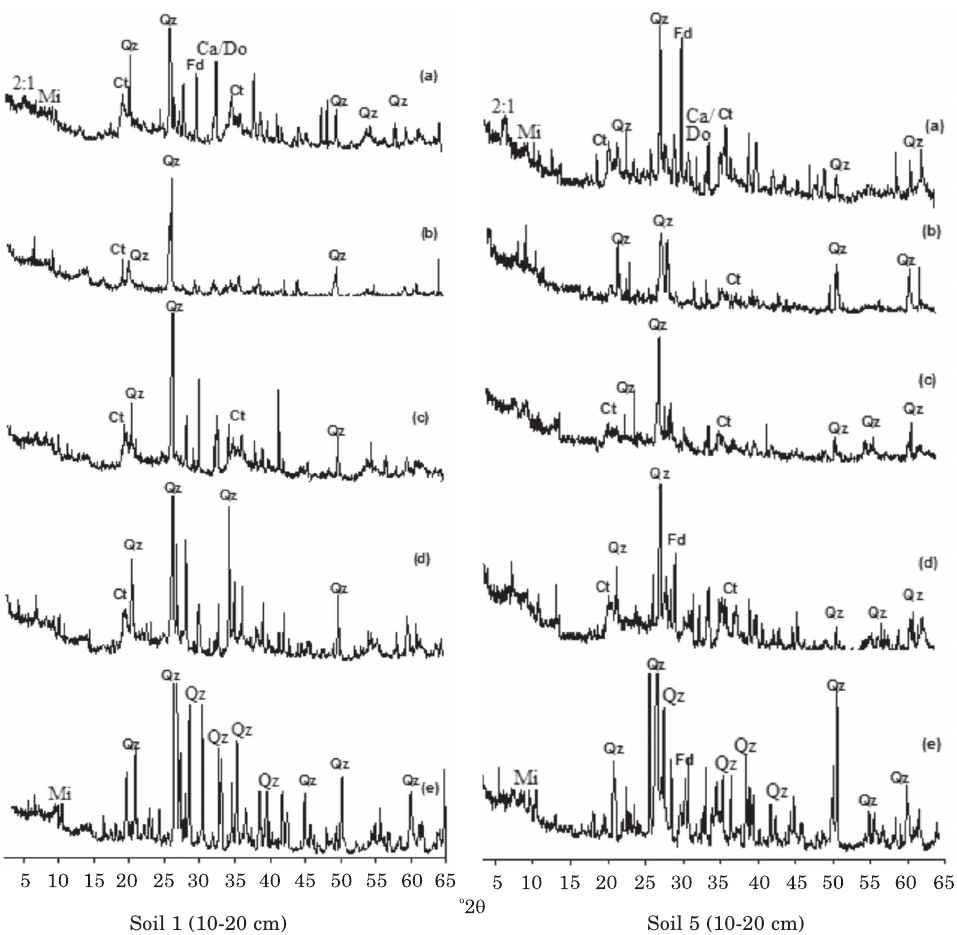
Soil 1 (10-20 cm) Soil 5 (10-20 Figure 3. X-ray diffraction of two soil samples showing the mineralogy evolution with the sequential treatments: (a) without treatment, (b) after CH 3 COONa, (c) after NaClO, (d) after DCB, (e) after NaOH. Ct: kaolinite, Fd: feldspar, Qz: quartz, Mi: mica, 2:1 - 2:1 secondary mineral, Ca/Do: calcite/dolomite.